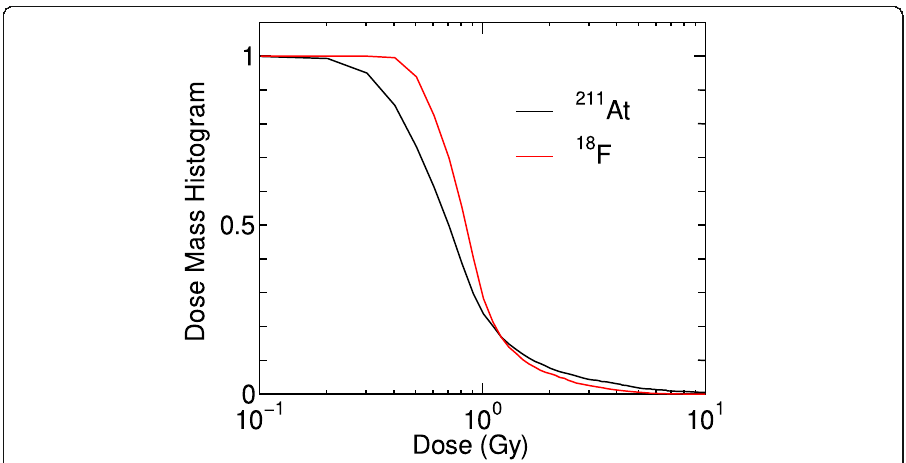
Fig. 7 Dose mass histogram (DMH) in the kidney for volunteer 1 with the injection of NKO-035 labeled with 211 At or 18 F. The mean doses were adjusted to 1 Gy for both